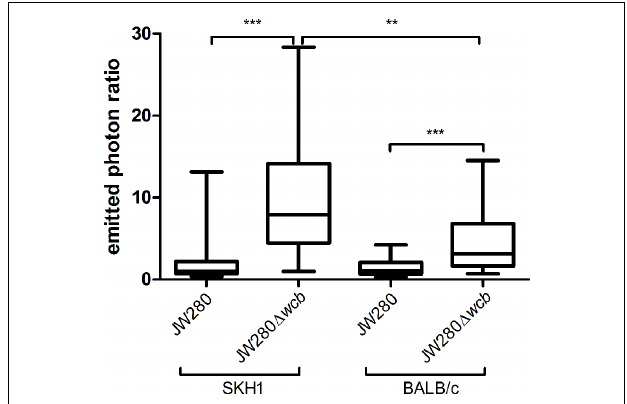
FIGURE 8 | Preferential colonization of the nasal cavity by B. pseudomallei . SKH1 and BALB/c mice were infected i.n. with JW280 (10 4 CFU) or JW280 (cid:2) wcb (10 6 CFU) and mice were imaged dorsally with an IVIS Lumina system beginning 24h post-infection.The background corrected nasal cavity to thoracic cavity ratio was evaluated at all time points for mice that developed lethal pneumonia.The collective of all experimental ratios were plotted for each group. Significant differences between groups are indicated by asterisks (** p < 0.01, *** p < 0.001).